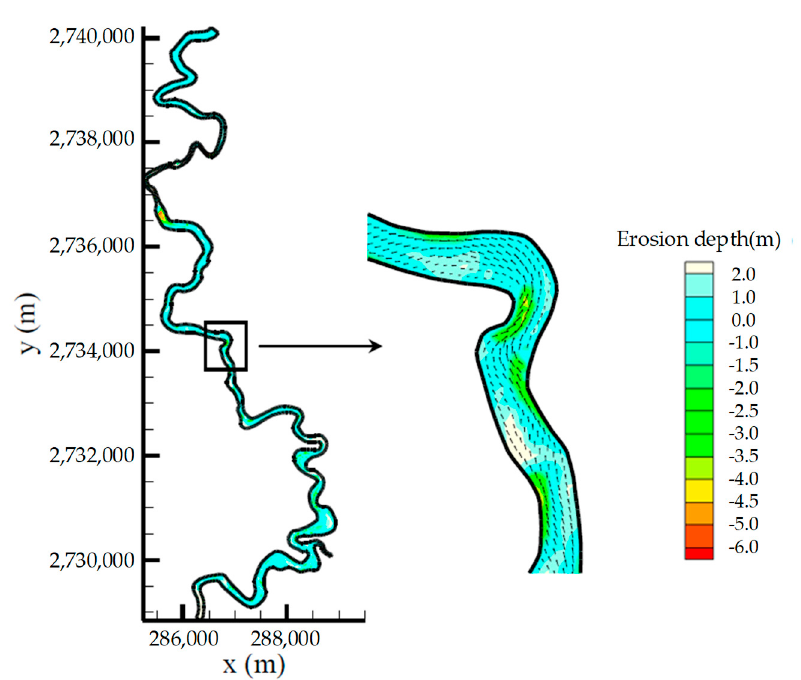
Figure 6. Flow field and erosion and deposition patterns at 10 am on August 8, 2009 (during the Typhoon Morakot event).